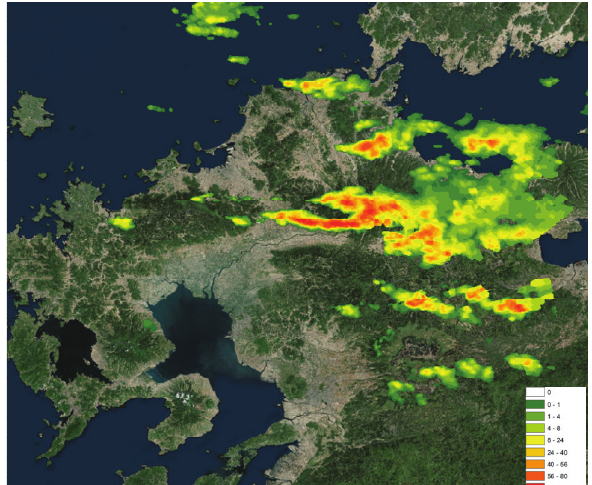
Figure 9. Result of inputting rainfall information of the X-band MP radar into GIS (2017.7.5 14:00).